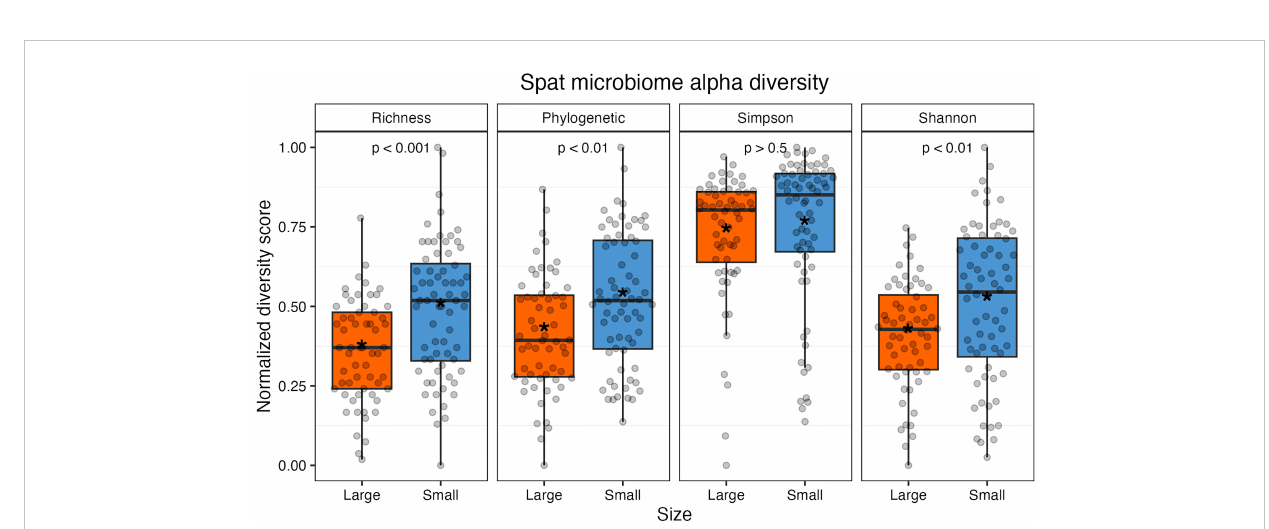
FIGURE 2 Alpha diversity measures normalized from 0 to 1 (from left: richness, Faith ’ s phylogenetic distance, Simpson index, and Shannon index). Individual samples are represented by gray points. All indices except Simpson were statistically signi fi cant between size classes. The colored boxes represent upper and lower quartiles, horizontal lines in boxes show the median values, and the vertical whiskers represent the most extreme values within the 1.5x interquartile range. Asterisks display mean